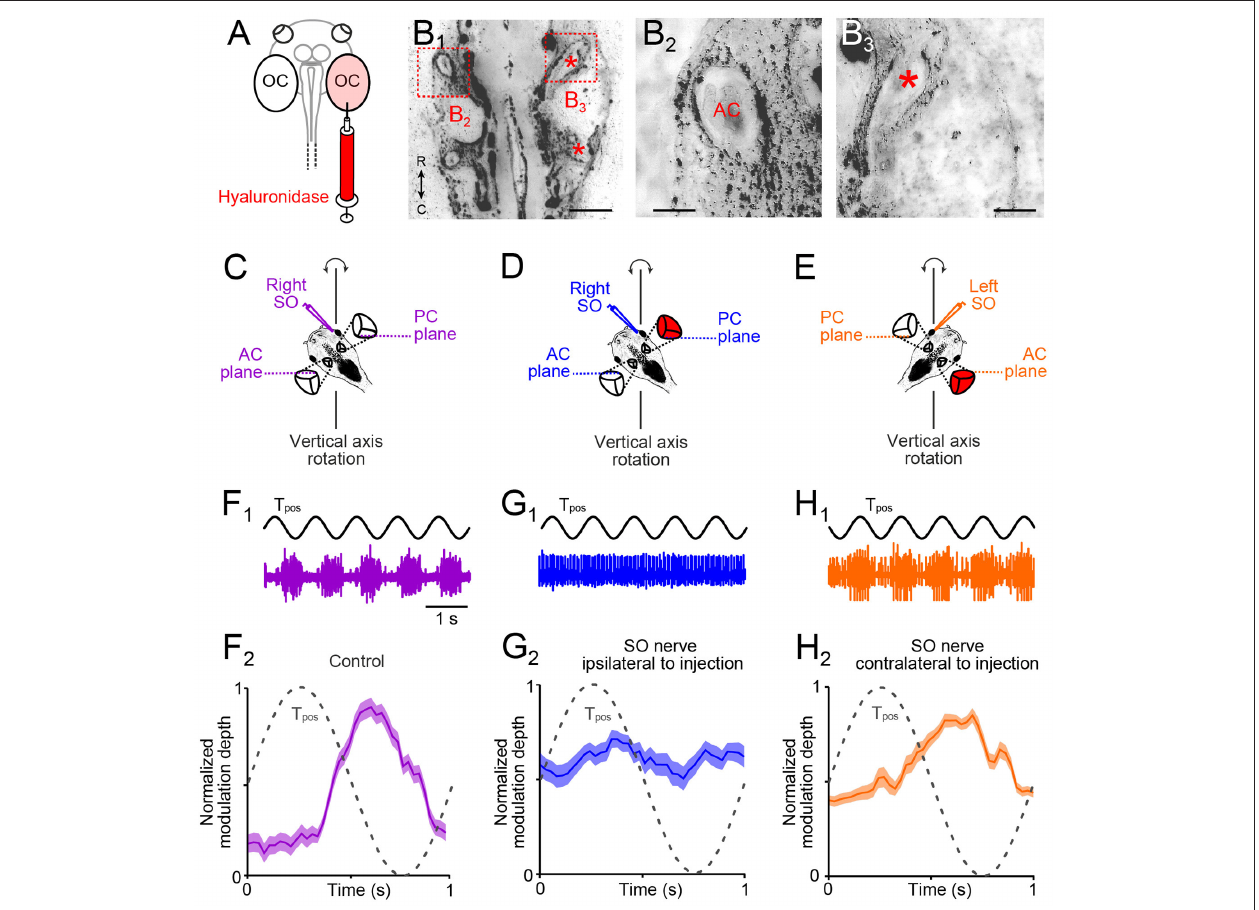
FIGURE 4 | Morpho-physiological correlates of impaired angular VOR in unilateral semicircular canal-deficient Xenopus tadpoles. (A) Scheme depicting the injection of the hyaluronidase into the right otic capsule (OC, light red). (B 1 –B 3 ) Overview (B 1 ) of a horizontal section through the head of a stage 55 tadpole, which received a hyaluronidase injection into the right otic capsule at stage 44; higher-magnification of the boxed areas in (B 1 ) of the left (B 2 ) and right inner ear (B 3 ) , indicating that semicircular canals developed on the left but not on the right side (red * in B 1,3 indicate putative locations of AC and PC). (C–E) Schematics of positional orientations of the preparations to record the right (C,D) and left (E) SO nerve during vertical-axis rotation; positional arrangements allow selective rotational stimulation at 1Hz and ± 60 ◦ /s peak velocity of the right PC—left AC (C,D) or left PC—right AC (E) , without stimulation of the utricle. (F) Spike discharge modulation of the right SO nerve during five cycles of sinusoidal turntable rotation (T pos ; black trace in (F 1 ) ) and averaged firing rate (mean ± SEM; F 2 ) over a single cycle (dashed sine wave in F 2 ) in a control. (G,H) Spike discharge modulation of the right (G 1 ) and left SO nerve (H 1 ) during sinusoidal rotation [T pos ; black traces in (G 1 ,H 1 ) ] in a preparation from a typical unilateral (right side) semicircular canal-deficient tadpole (red labeled inner ear); averaged firing rates (mean ± SEM; G 2 ,H 2 ) over a single cycle (dashed sine waves in G 2 ,H 2 ) show the loss of the excitatory (G 2 ) or inhibitory response component (H 2 ) ; the averaged firing rate modulation over a single cycle in (F 2 ,G 2 ,H 2 ) was obtained from 20–30 cycles, respectively. AC, PC, anterior, posterior vertical semicircular canal; SO, superior oblique; T pos , stimulus position of the turntable, C, caudal; R, rostral. Calibration bar represents 2mm in (B 1 ) and 0.5mm in (B 2 ,B 3 )